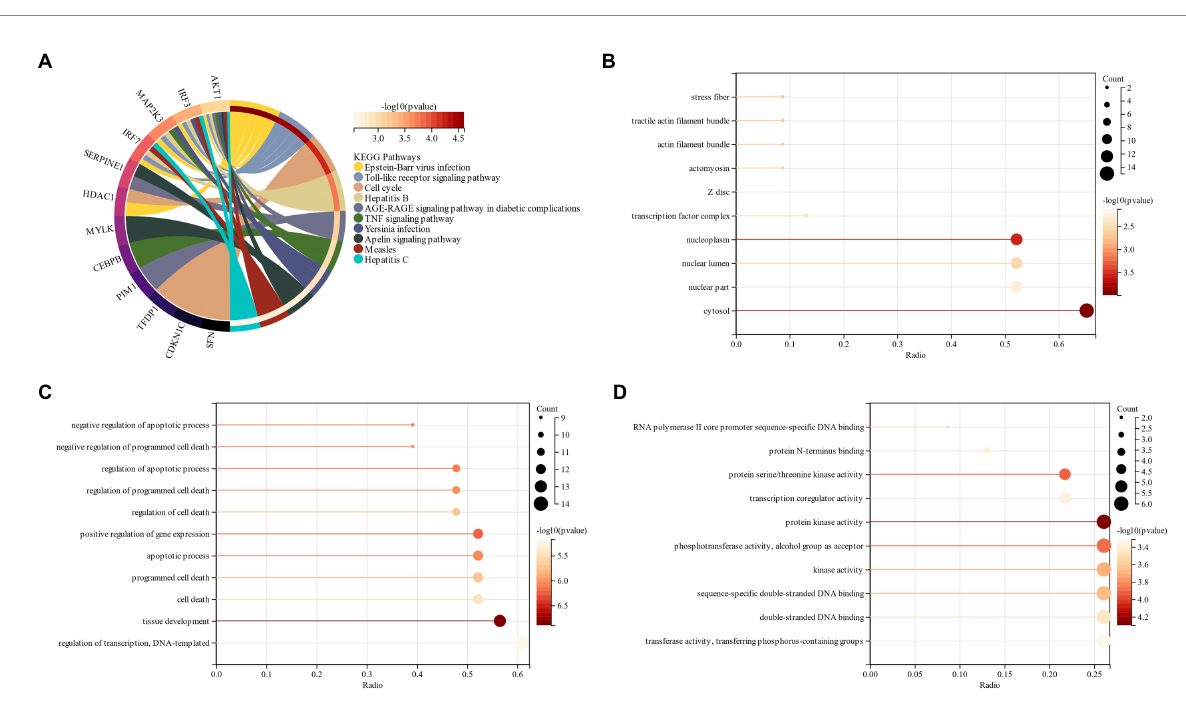
FIGURE 5 (A) KEGG analysis of intersected genes related to schizophrenia and cell senescence; (B) : GO analysis of the intersected genes of schizophrenia and cell senescence (CC); (C) : GO analysis of the biological process (BP) of intersected genes related to schizophrenia and cell senescence; (D) : GO Analysis of Molecular Function (MF) of intersected genes related to schizophrenia and cell senescence.